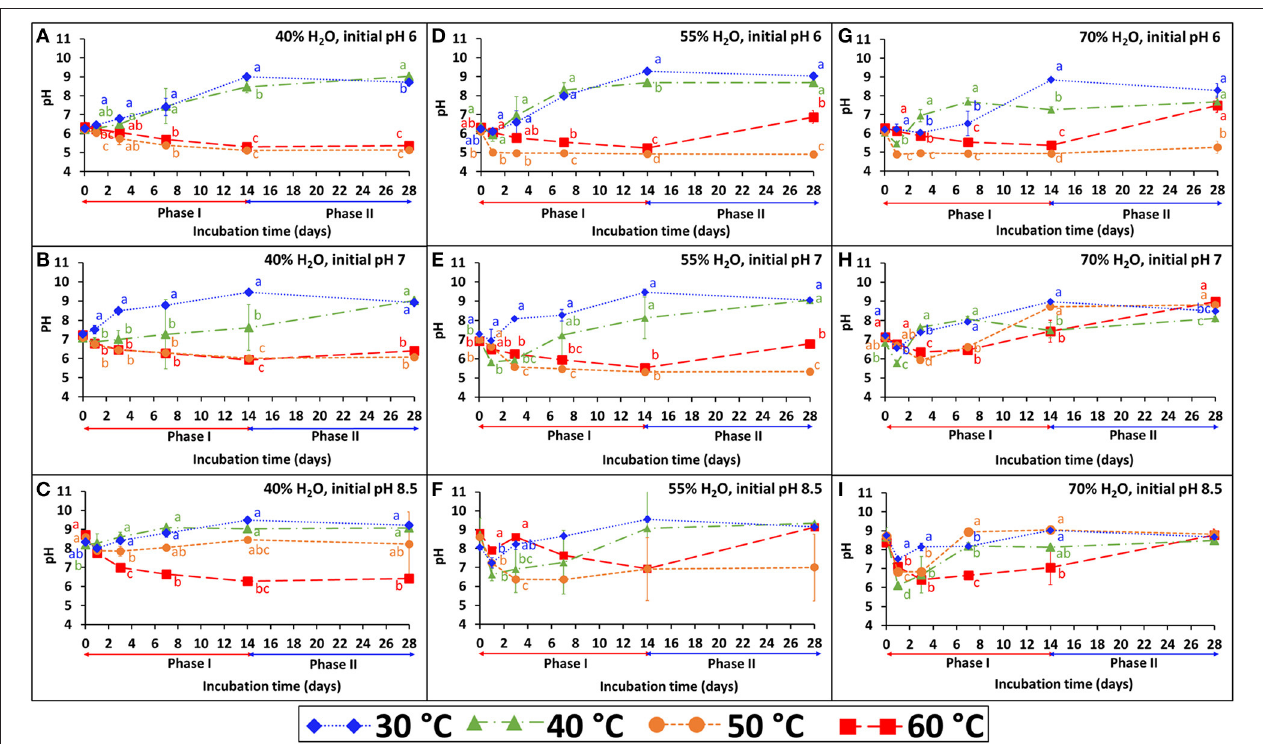
FIGURE 2 | pH dynamics during incubation of broiler litter (BL) at different temperatures (30, 40, 50, and 60 ◦ C), water content (40, 55, and 70%) and initial pH (6, 7, and 8.5). The different incubation temperatures were applied during phase I (weeks 1–2), while at phase II (weeks 3–4) the incubation temperature was 30 ◦ C. Error bars represent the standard deviations of triplicate vessels. Letters denote significant differences between treatments at time intervals (Tukey-Kramer HSD; P ≤ 0.05). The figures are grouped according to water contents of 40% (A–C) , 55% (D–F) , and 70% (G–I)